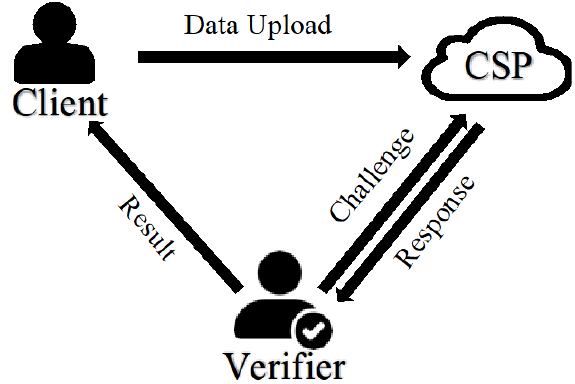
Figure 1. Overview of data integrity auditing.